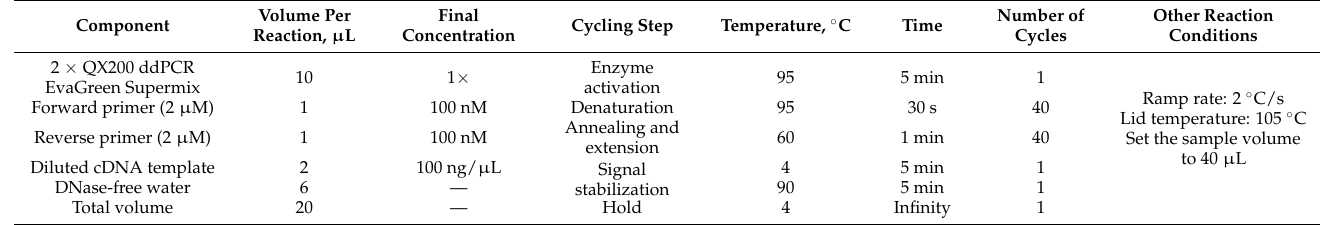
Table 2. The reaction system and procedure of droplet digital